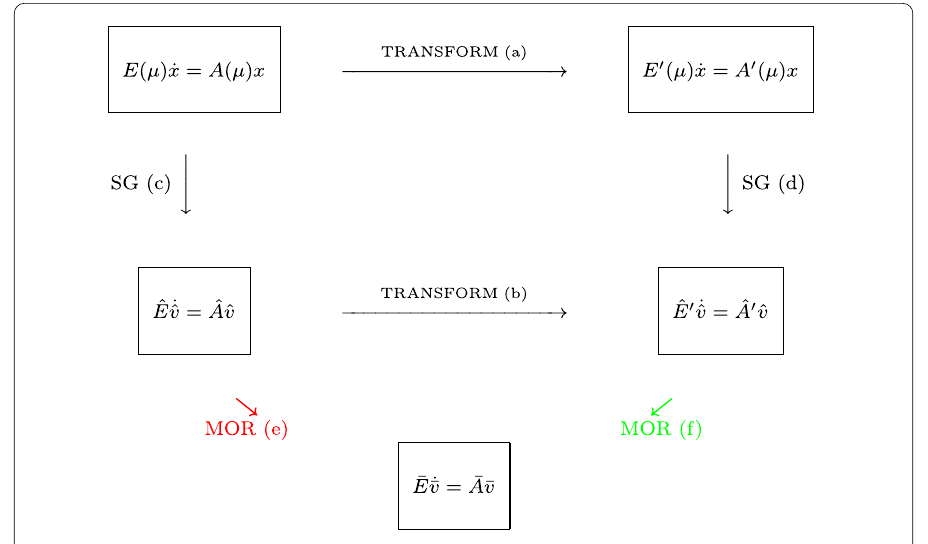
Figure 2 Flowchart for transformations, stochastic Galerkin (SG) projections and model order reduction (MOR). Inputs and outputs are not